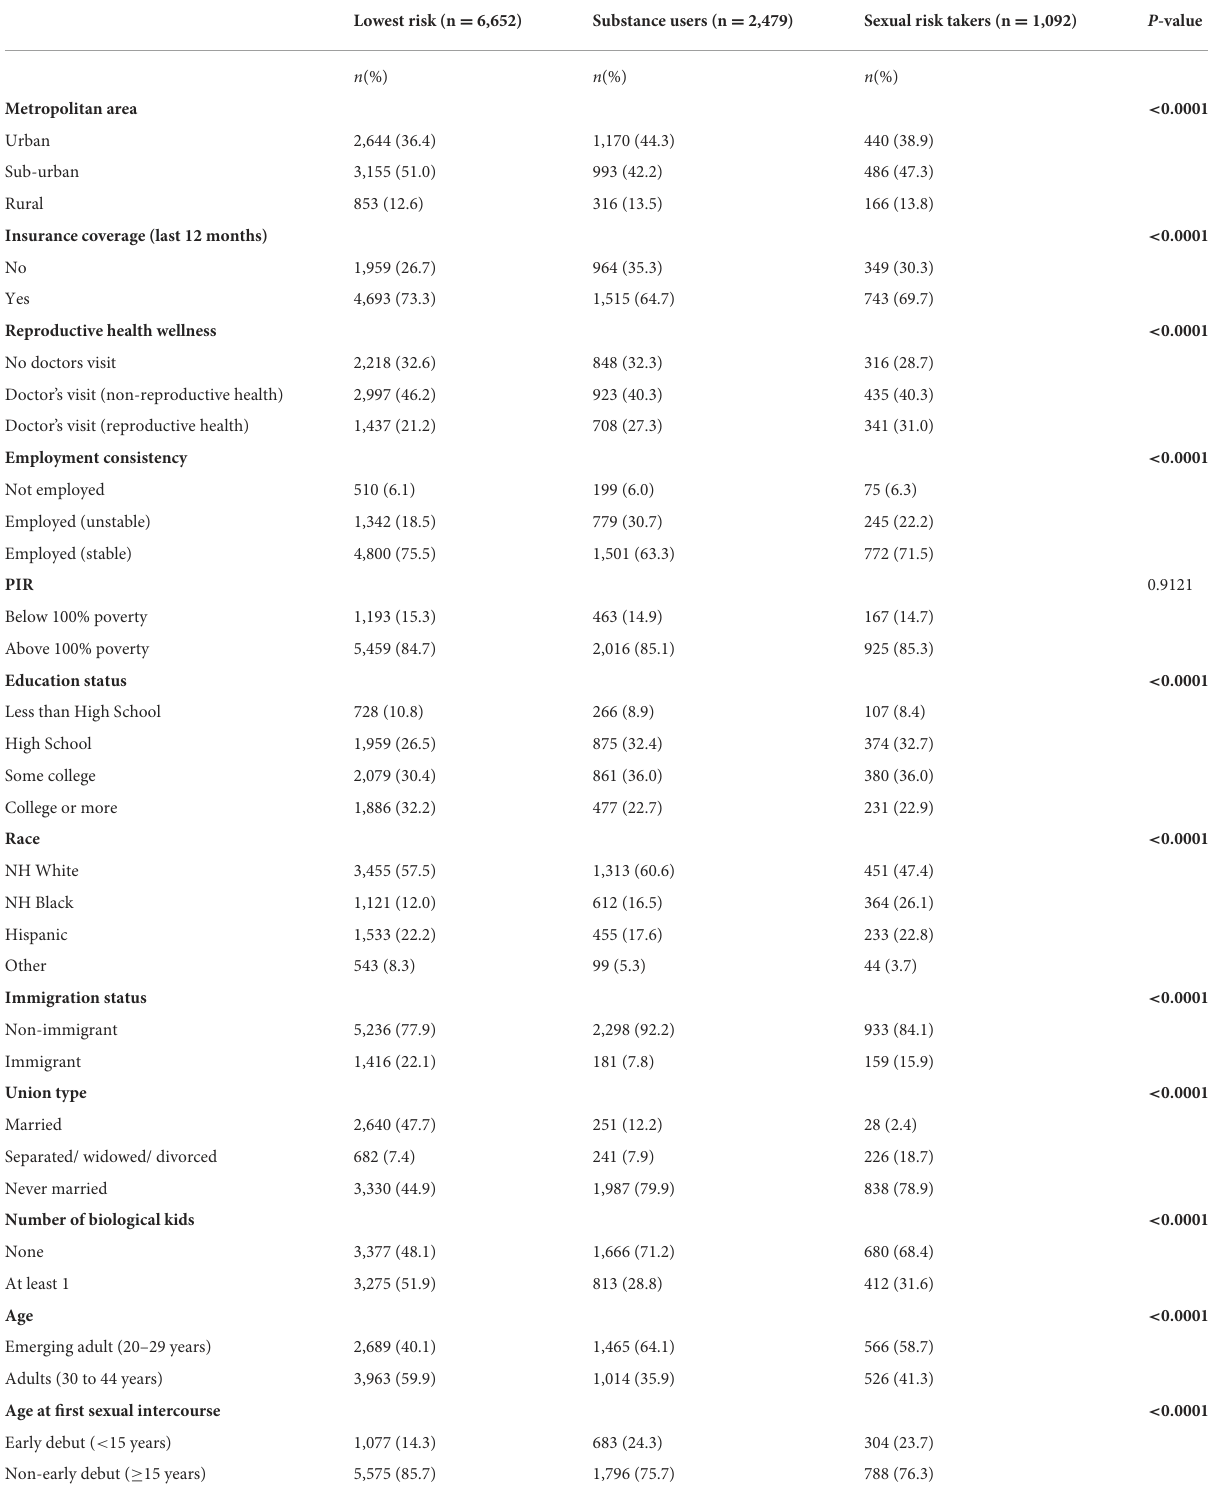
TABLE 3 Weighted distributions of social determinants of health by men’s preconception health